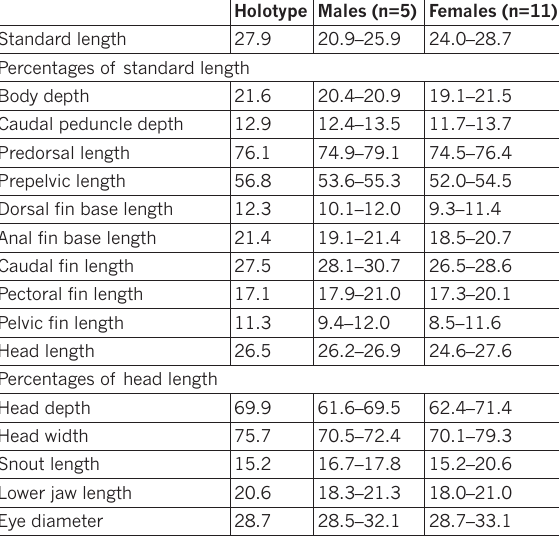
Table 3. Morphometric data for the holotype and paratypes of Melanorivulus amambaiensis sp.